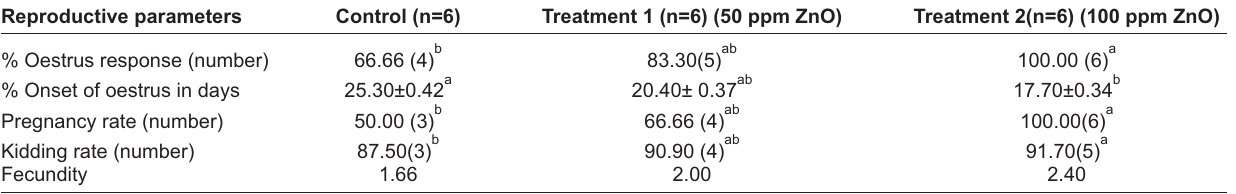
Table-1: Effect of zinc supplementation on the reproductive performance of Teressa goat. Reproductive parameters